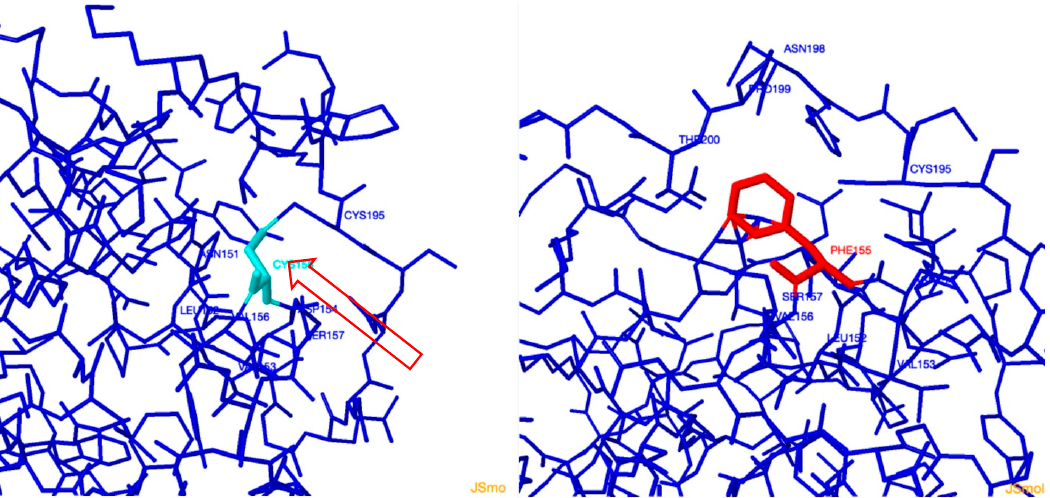
Figure 5. Three-dimensional structure analysis using missense 3D showing the effect of the new missense mutation c.509G>T (p.Cys170phe) in CTSK gene causing pycnodysostosis. Red arrow referring to the disulphide bond in the wild type protein structure which will get lost in the mutant protein. The cyan structure is representing the Cysteine residue in the wildtype protein and the red structure is representing the phenylalanine residue in the mutant structure.